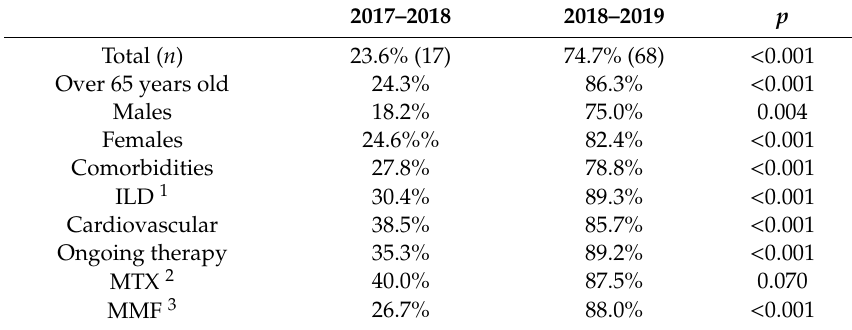
Table 3. Changes in S. pneumoniae vaccination coverage between the 2017–2018 and 2018–2019